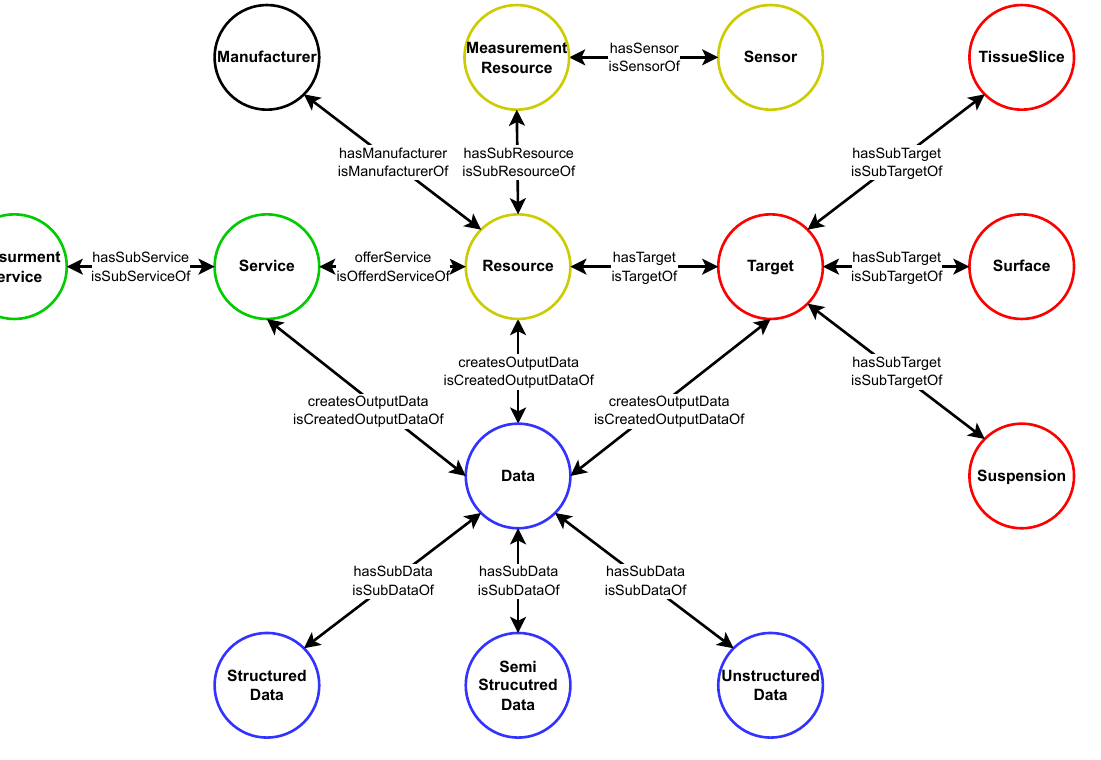
Figure 5. Top-level Knowledge Graph for Research Data